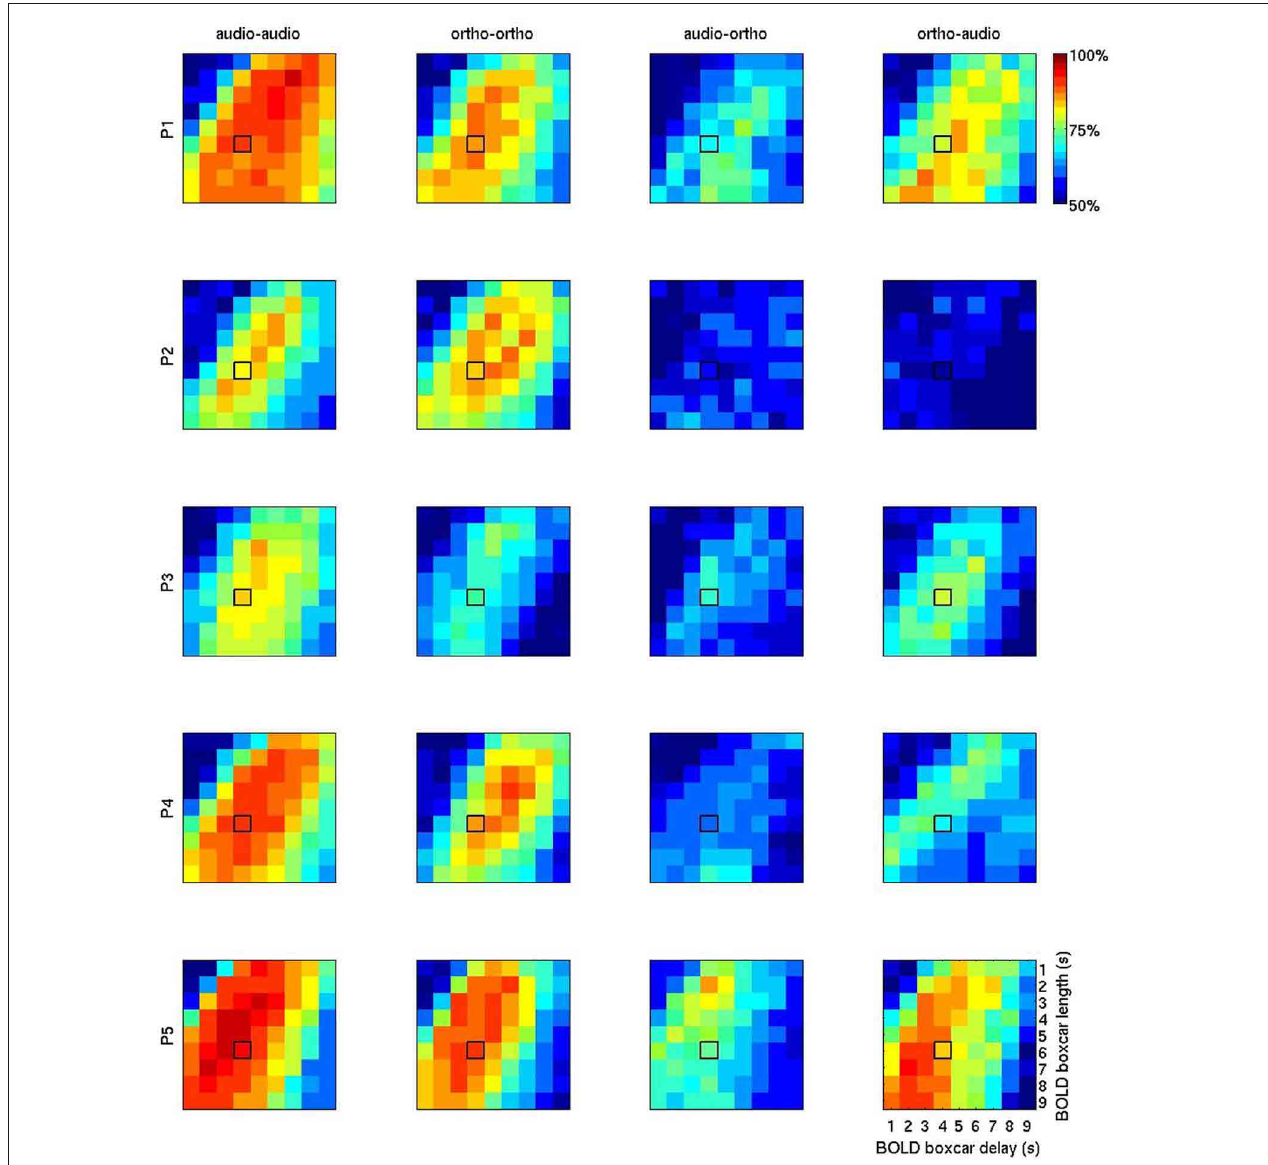
FIGURE 5 | BOLD accuracy grids containing the overall results of 1620 ( = 9 × 9 × 4 × 5) machine learning computations using PLR. The first two columns (“audio-audio” and “ortho-ortho”) stand for the results of the within-session uni-modal predictions for P1 (row 1), P2 (row2), P3 (row3), P4 (row4), and P5 (row5). The columns 3 (“audio-ortho”) and 4 (“ortho-audio”)